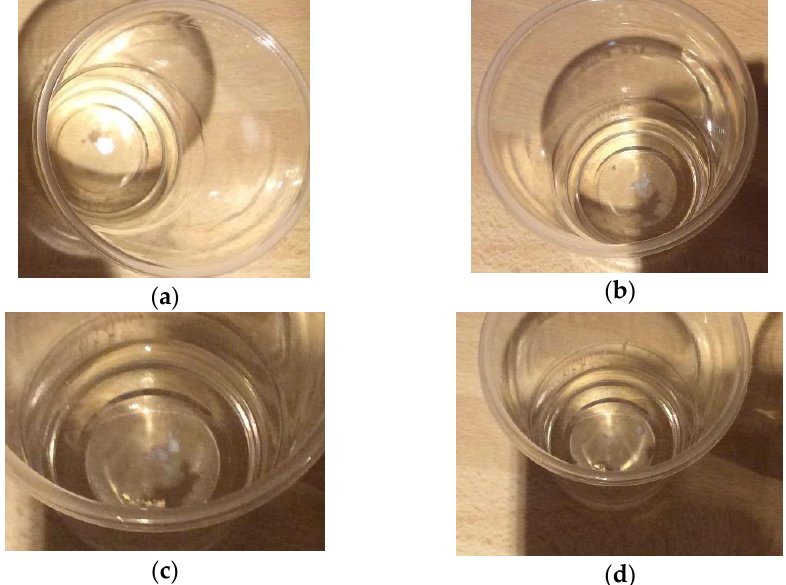
Figure A2. Drop test showing emulsions of droplets deposited on pure sunflower oil: ( a ) at the start of the test; ( b ) after 3 min, when the emulsion droplet was partially dispersed, but to some extent maintained its original shape; ( c ) after 4 min, when the emulsion droplet was partially dispersed and losing it original integrity, shape and size; and ( d ) after 5 min, when the emulsion droplet was further dispersed and transformed into a number of smaller emulsion droplets.